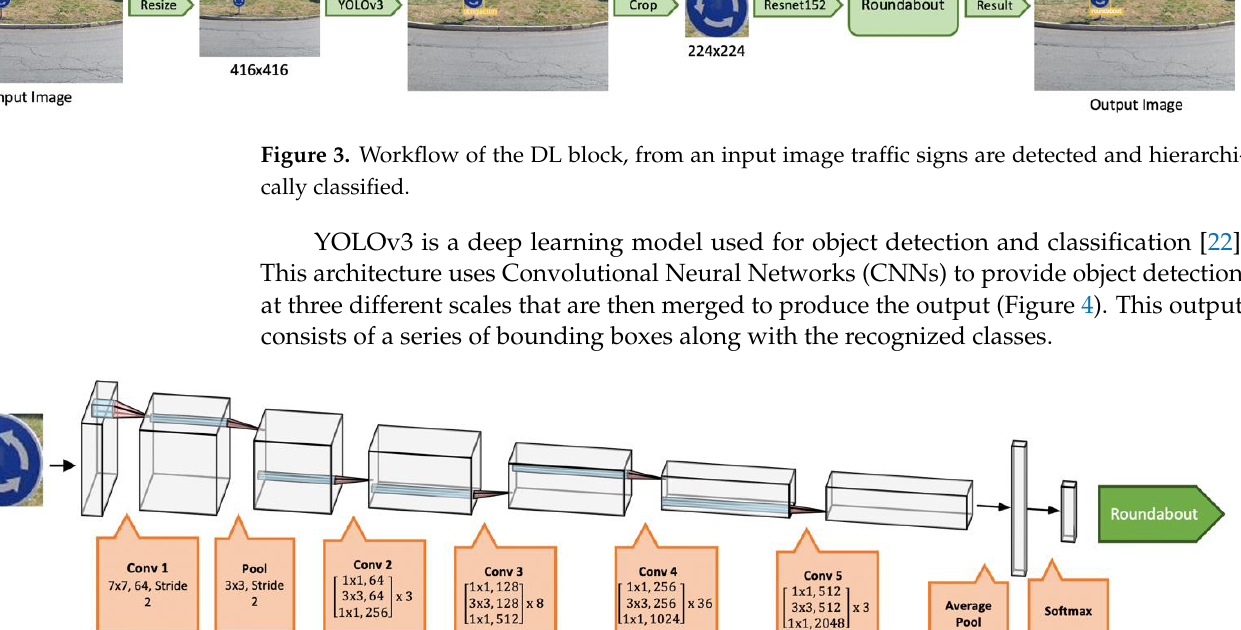
Figure 4. Schematic representation of the YOLOV3 architecture.